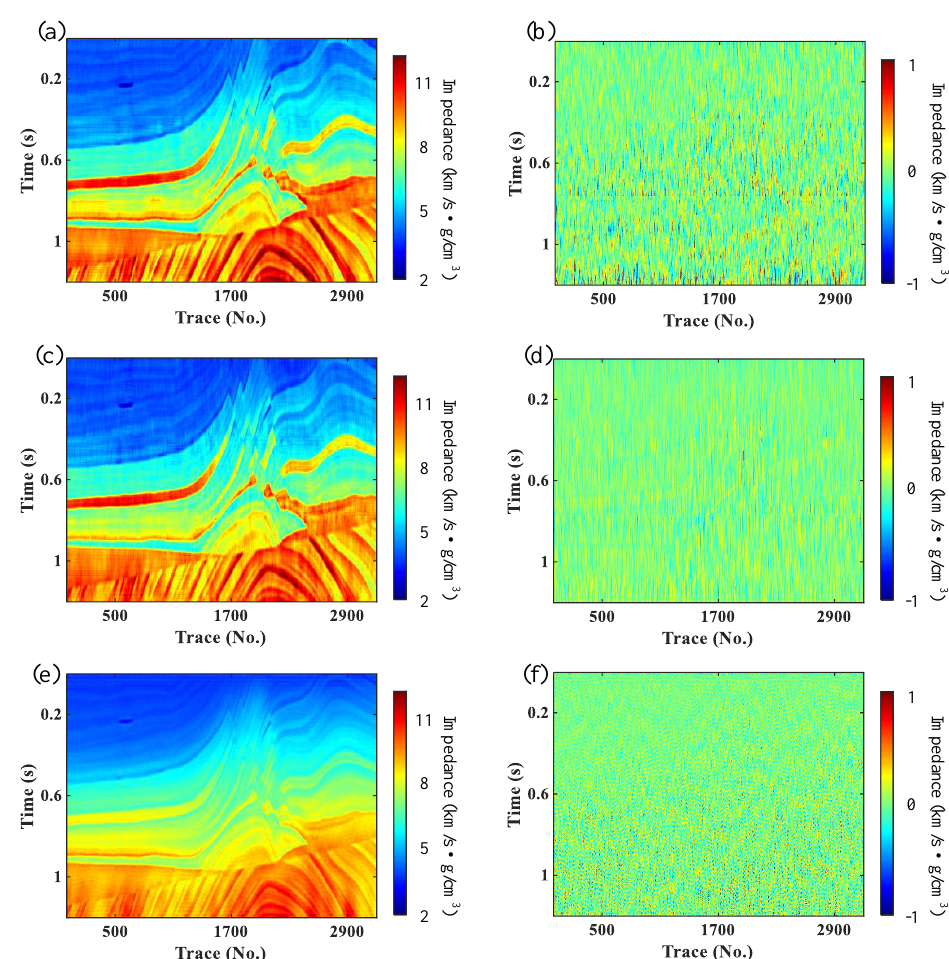
Figure 7. ( a ) The inverted impedance using SSII with f-x filtering. ( b ) The residual profiles of SSII inversion results without and with f-x filtering. ( c ) The inverted impedance using MSII with f-x filtering. ( d ) The residual profiles of MSII inversion results without and with f-x filtering. ( e ) The inverted impedance using MDII with f-x filtering. ( f ) The residual profiles of MDII inversion results without and with f-x filtering. Table 1. The RMSE of the inversion results (Marmousi model) of SSII, MSII and MDII combined with and without f-x filtering.